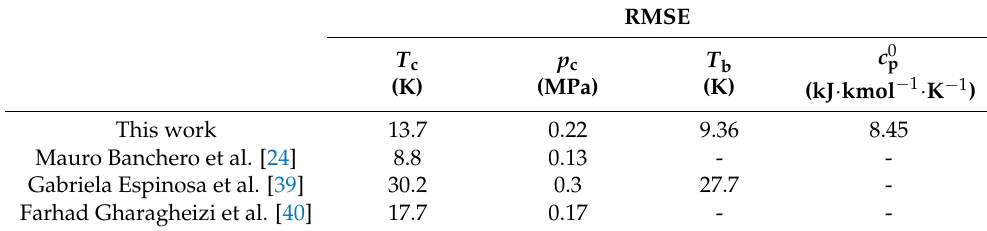
Table 3. Prediction accuracy comparison between this work and the other